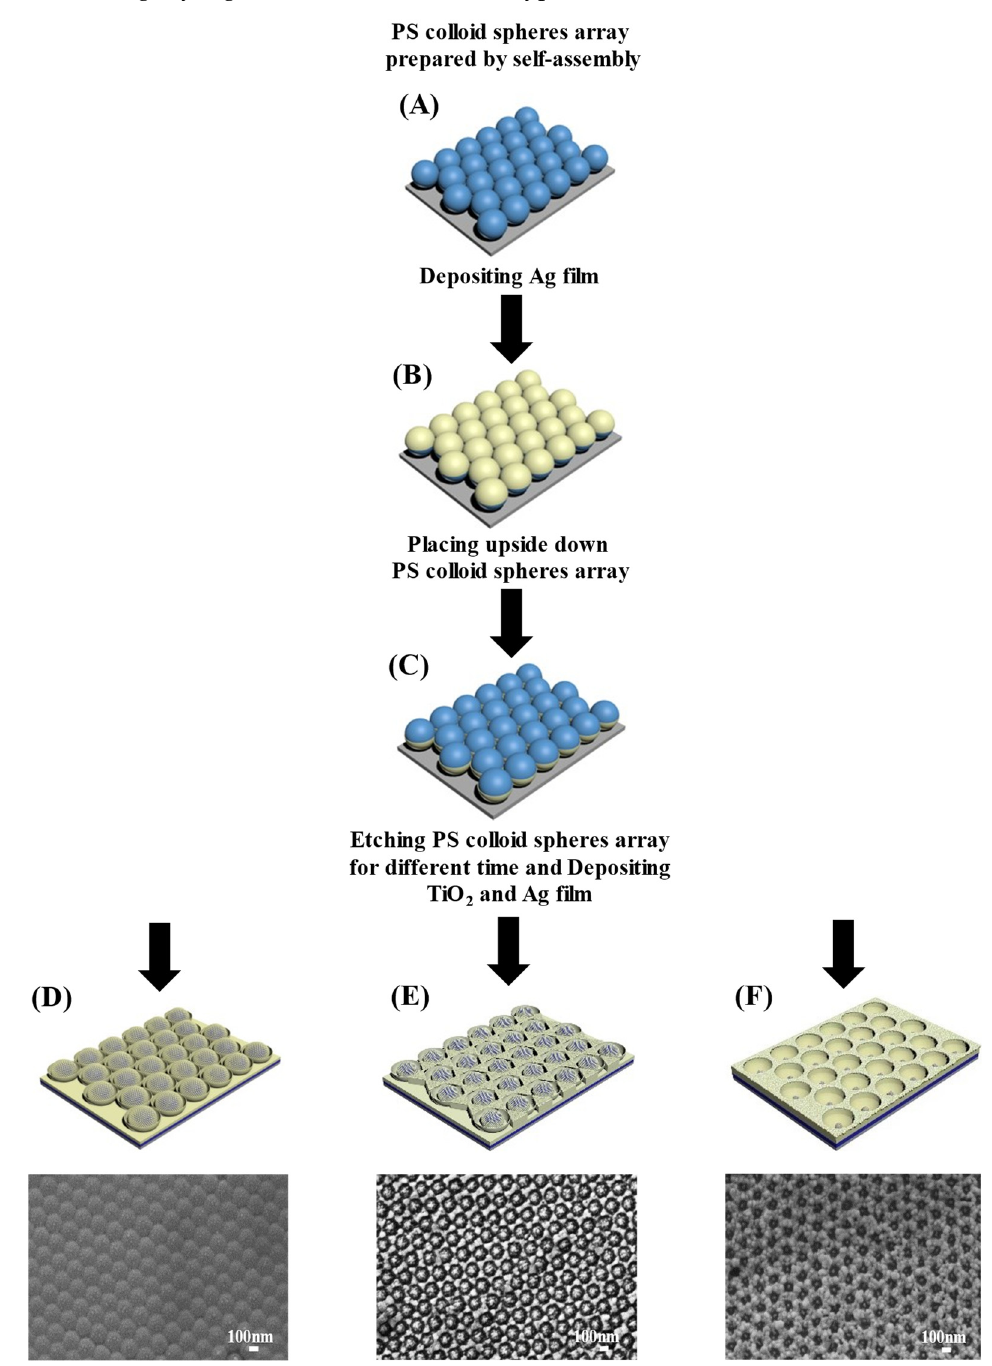
Figure 1. The schematic of preparation of the Ag/TiO 2 /Ag nano structural arrays. ( A ) PS colloid